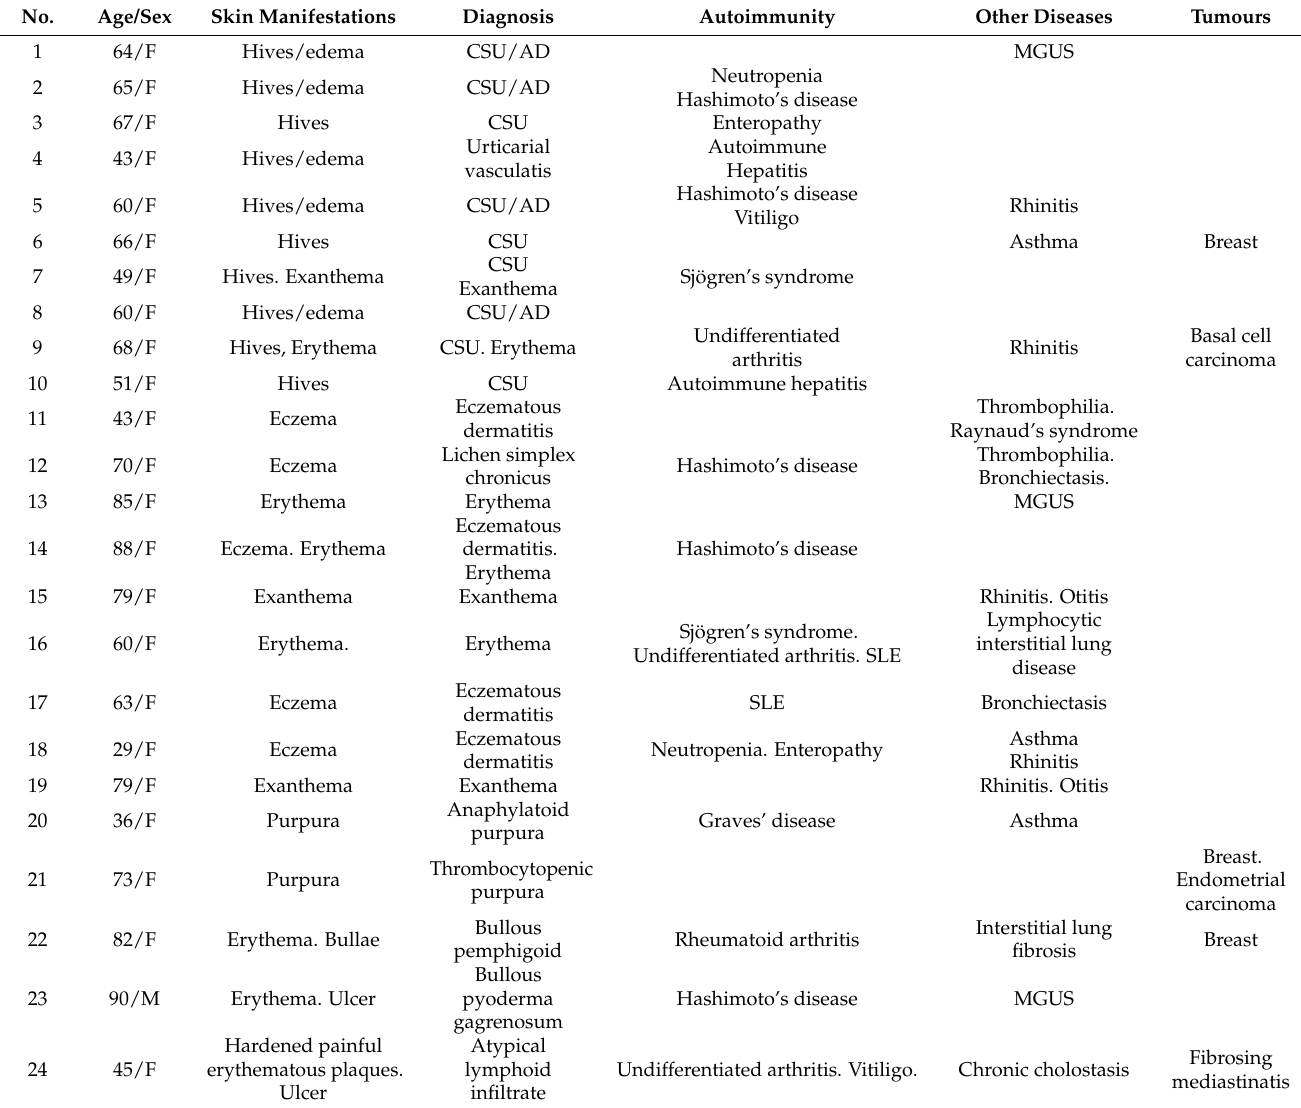
Table 1. Distribution of skin manifestations, autoimmune diseases, and malignancies in patients with